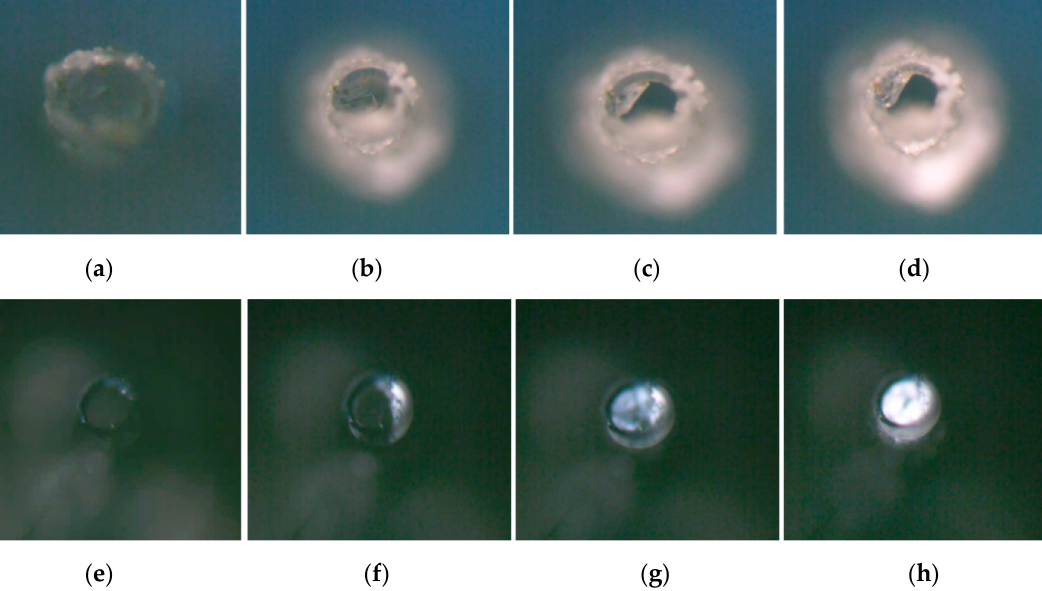
Figure 5. The polarizing microscope of the changing process of a solution in a 10- µ m capillary vertically. ( a ) The crystallization of the NaCl solution in the pipe orifice and the outer wall of the tube. ( b ) The crystallization area of the NaCl solution increased. ( c ) The crystals in the capillary dehydrated. ( d ) The crystals completely desiccated. ( e ) The Na 2 SO 4 solution began to crystallize on the inner wall of the pores. ( f , g ) The crystallization area of the Na 2 SO 4 solution in the pores increased continuously, and it was in a continuous and dynamic state of alternating crystallization and dissolution. ( h ) The Na 2 SO 4 solution crystalized and desiccated in the pores.